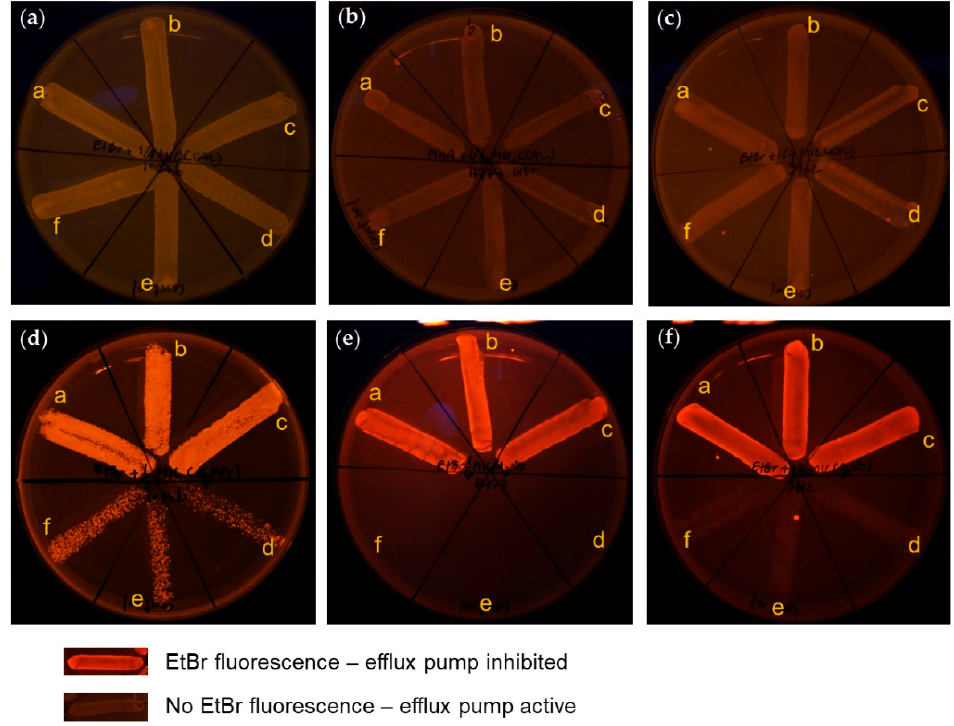
Figure 8. Phenotypic efflux pump inhibiting effect of antibacterial agents: ( a–c ) 2 µg/mL EtBr-agar supplemented with ¼ MIC of CAZ; ( d–f ) 2 µg/ml EtBr-agar supplemented with ¼ MIC of AgNPs; ( a , d ) against B. pseudomallei strain 1026b; ( b , e ) H777; ( c , f ) and 316c. Broth conditions for 30th bacterial generations passage: (inset, a – c ) B. pseudomallei in broth supple- mented with ¼ MIC of each agent; (inset, d – f ) and B. pseudomallei in untreated control broth.